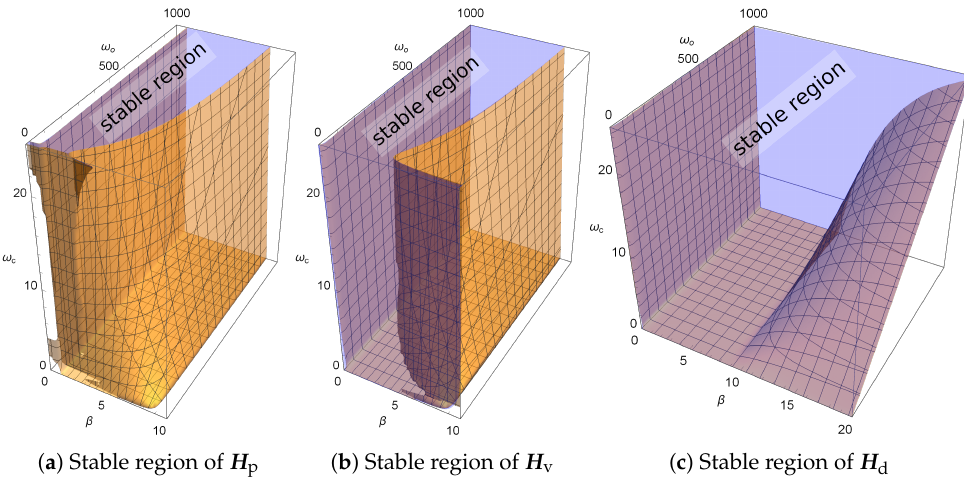
Figure 2. Stable regions for different v variants. These regions are bounded by the computed surfaces and are marked in